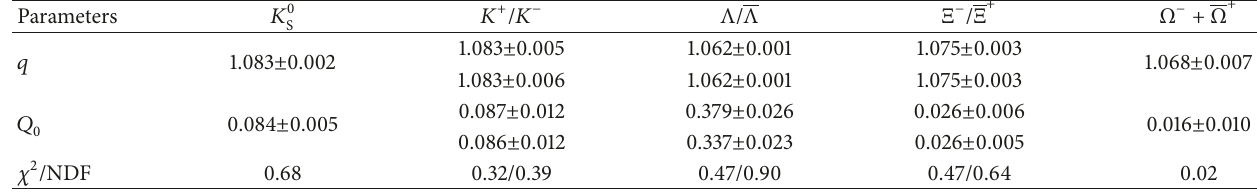
Table 1: The values of 𝑞 , 𝑄 0 , and 𝜒 2 /NDF obtained from the analyses of STAR data [44] in 𝑝 + 𝑝 collisions at √𝑠 = 200 GeV.